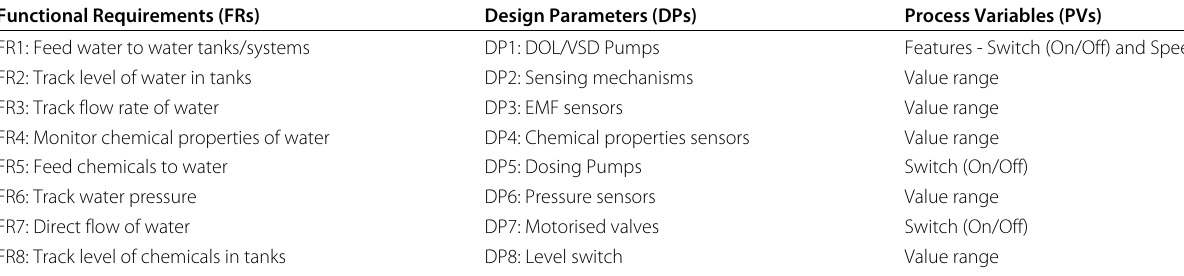
Functional Requirements (FRs) Design Parameters (DPs) Process Variables